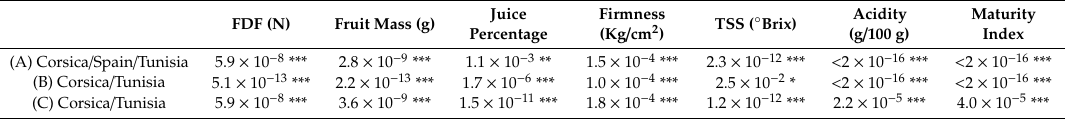
Table 1. Probability of a site e ff ect on fruit attributes at the three sites (A), in Corsica and Tunisia by the end of January (B) and in Corsica and Tunisia by the end of February (C). Data are means ( n = 12). *, **, *** indicate significance levels at p < 0.01, p < 0.001 and p < 0 respectively. FDF (N) Juice Percentage